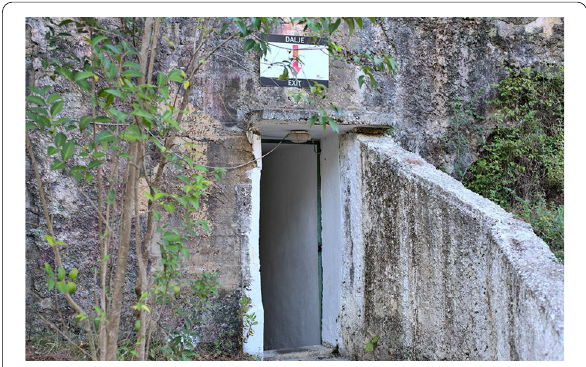
Fig. 4 Picture of bunkart external context of Bunkart